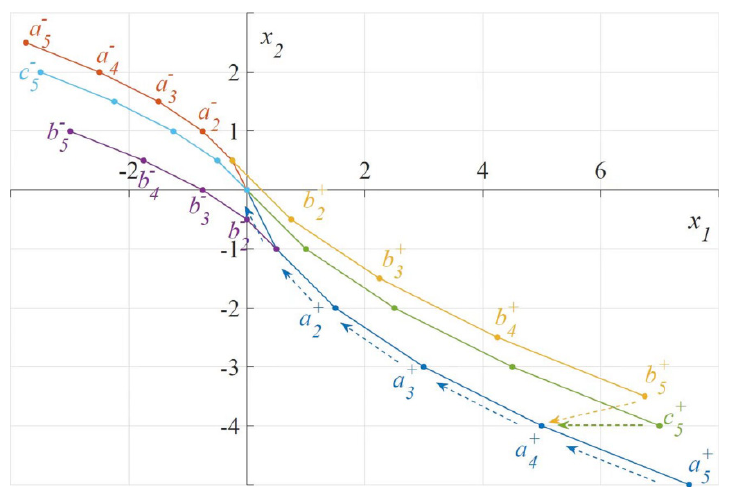
Figure 3. Schematic diagram of Phase 2 plane.